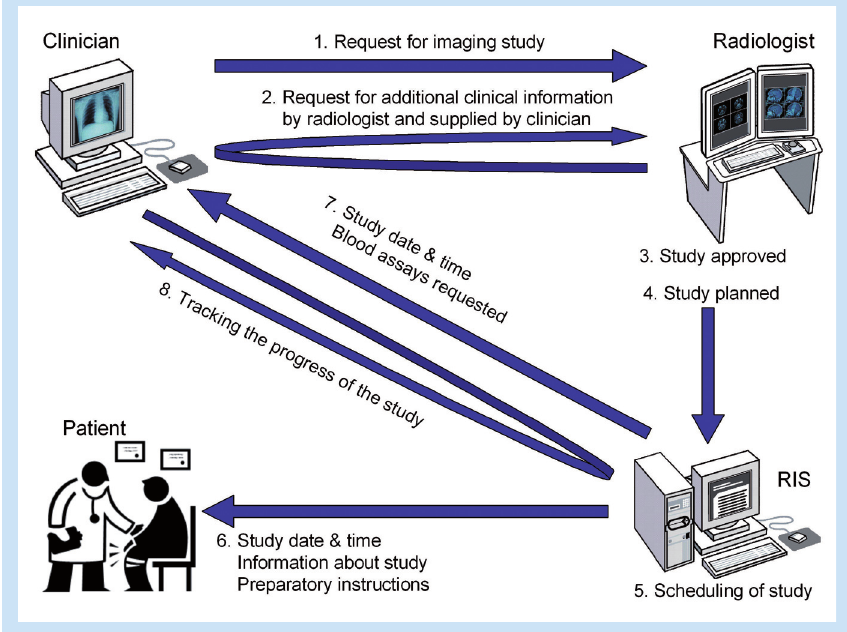
Fig. 1. This is a diagrammatic representation of the ordering of an imaging examination workflow. Step 1 shows the clinician requesting an examination. Step 2 shows the radiologist enquiring about more clini- cal information to plan the optimal examination. Step 3 shows the radiologist approving the request and in Step 4 he plans the examination. Step 5 shows the automatic scheduling of the examination. Step 6 shows the feedback given to the patient regarding the date and time of the examination, more information about the procedure (what it would entail, what are the risks & what are the benefits) and also